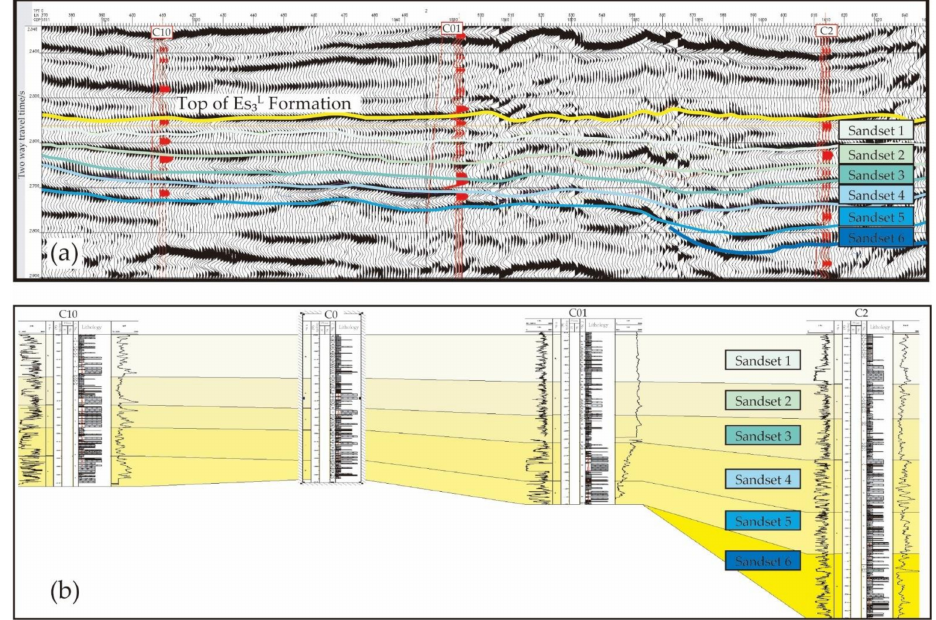
Figure 3. ( a ) W–E trending seismic profile interpretations of the northern Chezhen depression. ( b ) W–E trending well logging profile.